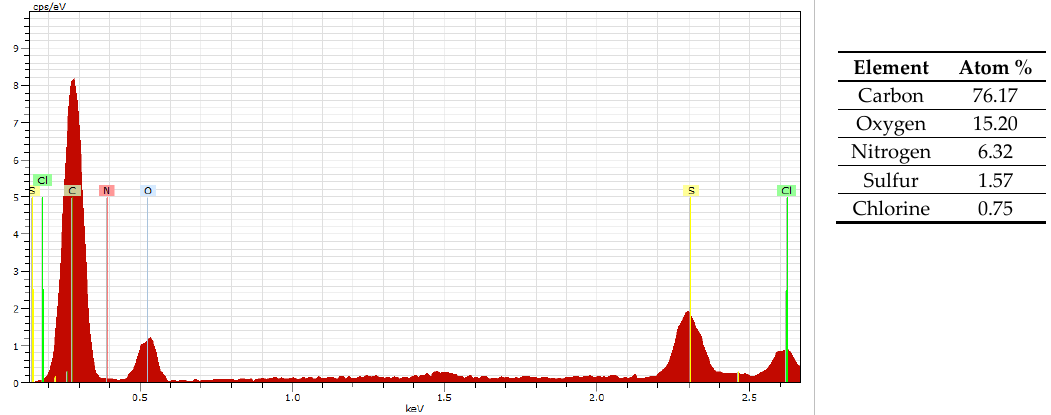
Figure 3. Energy Dispersive X-ray spectra and Atom Percent of C6-AGT.